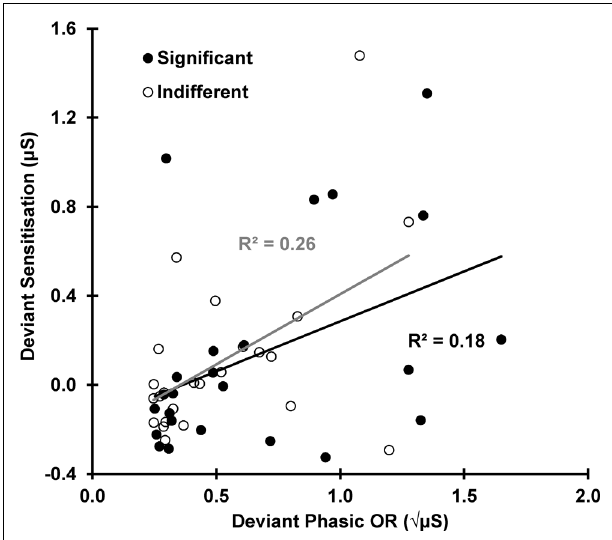
FIGURE 5 | Deviant sensitization (SCL: 12 minus 11) as a function of deviant ORs (SCR 11). sensitization appears to be dependent on the deviant ORs for both conditions.